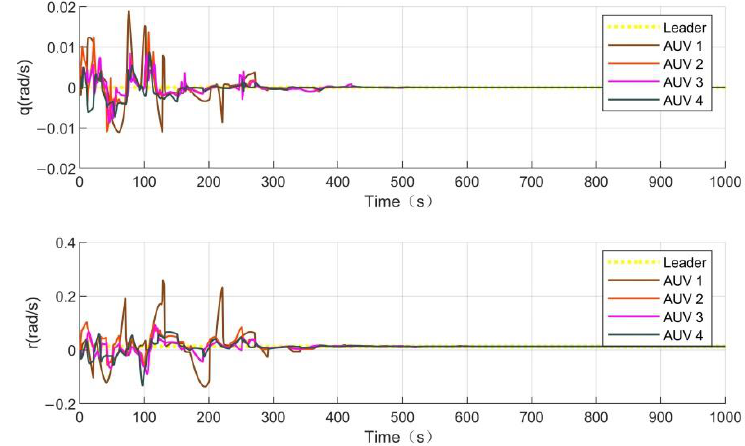
Figure 20. Angular velocity status of the AUV formation when using the controller in [13].